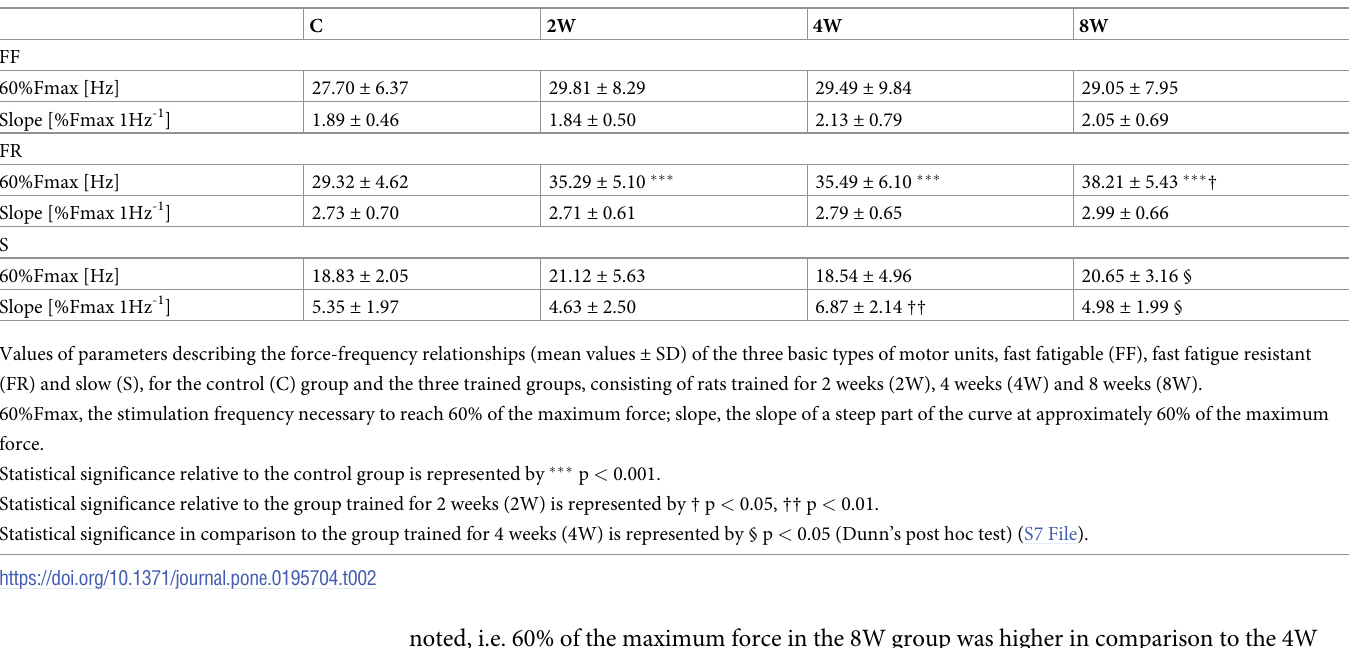
group (p = 0.03) and the slope in the 4W group was higher both for 2W (p = 0.01) and for the 8W group (p = 0.03) (Table 2).